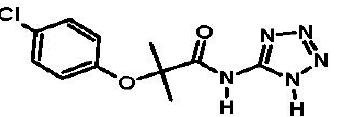
Figure 2. Chemical structure of 2-(4-chlorophenoxy)-2-methyl- N -(1 H -tetrazol-5-yl) propanamide (tetrazole analog of clofibric acid) (Compound 1 ).